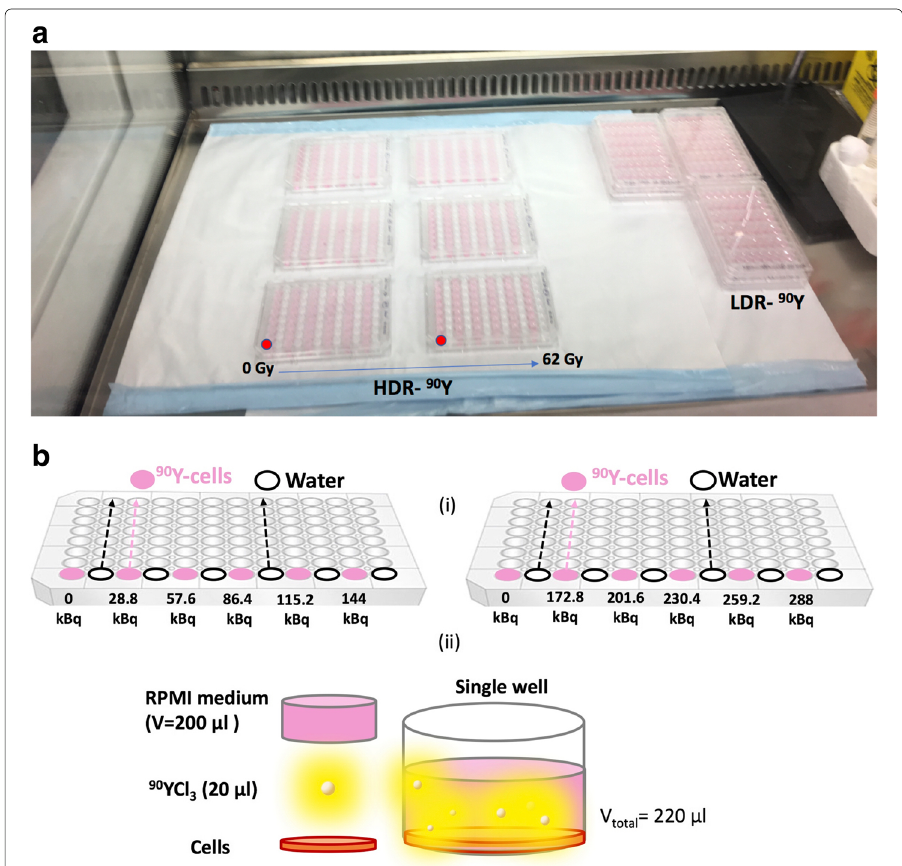
Fig. 2 Experimental set-up for 90 Y. a Two sets of 90 YCl 3 (HDR, LDR) activity concentrations were added to the cell plates. Each cell line was plated into two plates with range of 0–62 Gy. The red markers show row of wells that contains the cell without activity. b Schematic diagram illustrating (i) the distribution of cells and 90 Y source in two 96-well plates for HDR– 90 Y set (similar set-up was prepared for LDR– 90 Y set), (ii)